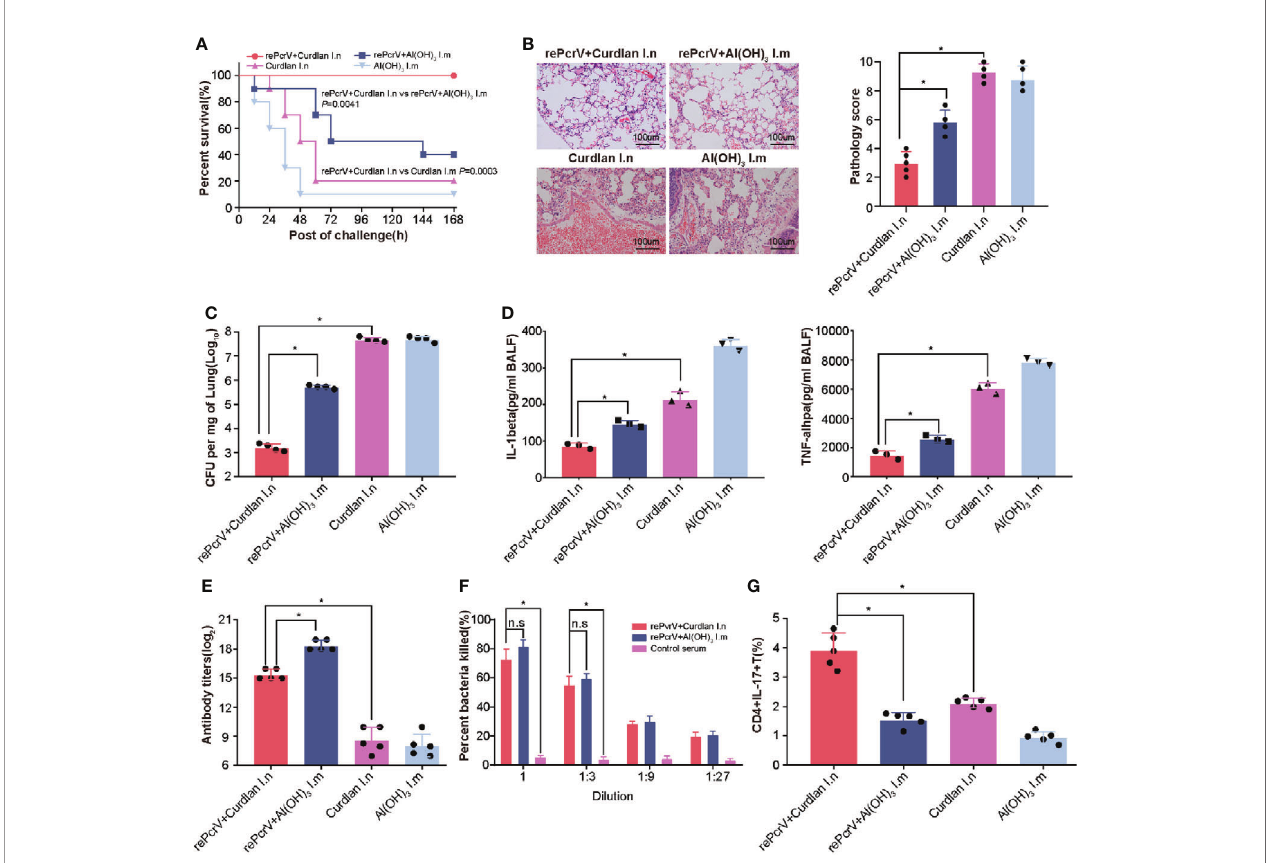
FIGURE 2 | Compared with intramuscular vaccination, intranasal vaccination with rePcrV enhanced protection. (A) Mice were immunized with rePcrV intranasally (i.n.) or intramuscularly (i.m.). The bar indicates the survival of mice (n = 10) after intratracheal injection with a lethal dose of PA XN-1. The survival rate of the i.n. group was signi fi cantly higher than that of the i.m. group. (B) HE staining of lungs from immunized mice 24 h after infection with a sublethal dose of PA XN-1. Images were captured at 100× magni fi cation. (C) Evaluation of the bacterial load in the lung in PA XN-1 − infected mice (n = 4). The bar represents the average and SE of the log CFU of PA XN-1 per mg of lung tissue. (D) Quantitative measurement of TNF- a and IL-1 b in the lungs (n = 3). The data are shown as the mean ± SE. (E) The bar represents the titer of anti-rePcrV IgG antibodies in the serum of immunized mice (n = 5). (G) The opsonophagocytic killing activity of the serum from immunized mice. Serum samples from immunized mice were diluted and incubated with PA XN-1. The bar represents the percentage of killed bacteria in a series of dilutions. The data are presented as the mean ± SE. (F) Frequency of CD4 + CD17 + T cells in the lungs of mice two weeks after the last immunization. The bar represents the frequency of the cells in each group. The “ * ” indicates a signi fi cant difference at P < 0.05. The “ n.s ” means “ no signi fi cant difference ”